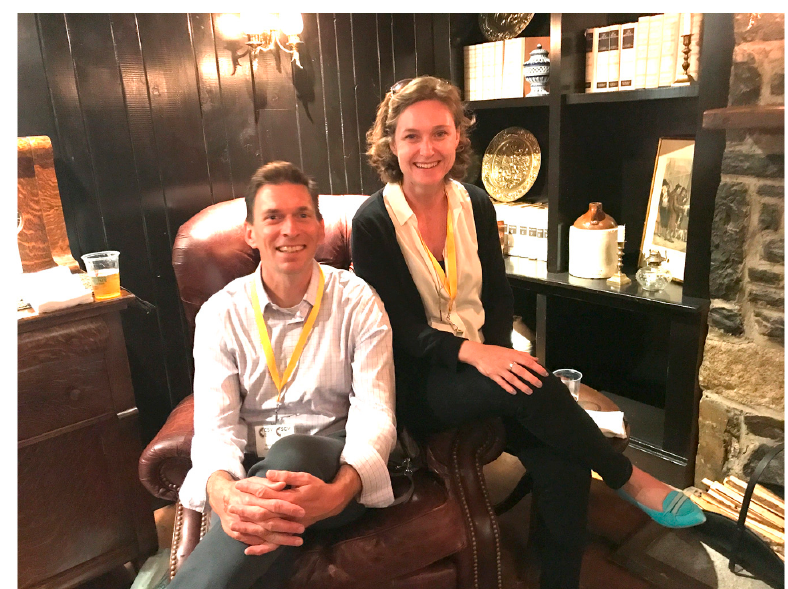
Figure 7. CSV Co-Founders Craig McCormick and Nathalie Grandvaux in Mr. Keith’s Office at the historic Alexander Keith’s Brewery in Halifax, Nova Scotia.